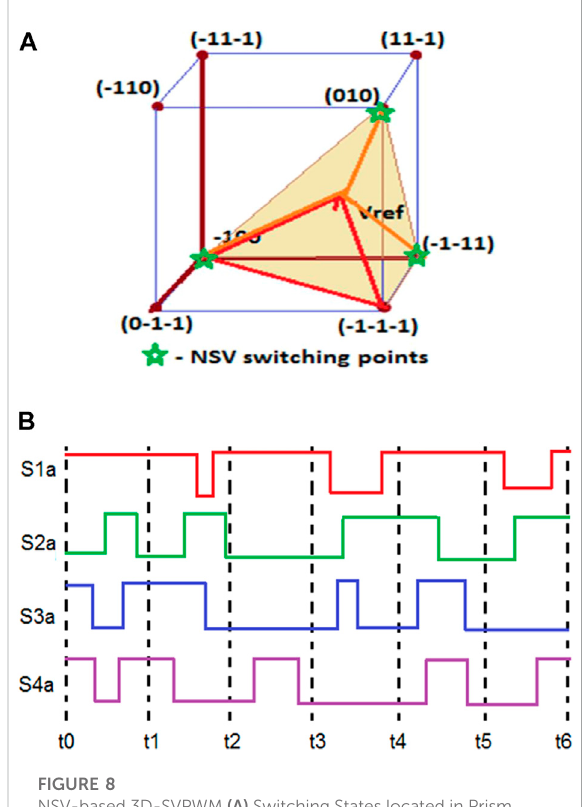
FIGURE 8 NSV-based 3D-SVPWM (A) Switching States located in Prism 1 (B) Pattern of Switching Pulse.